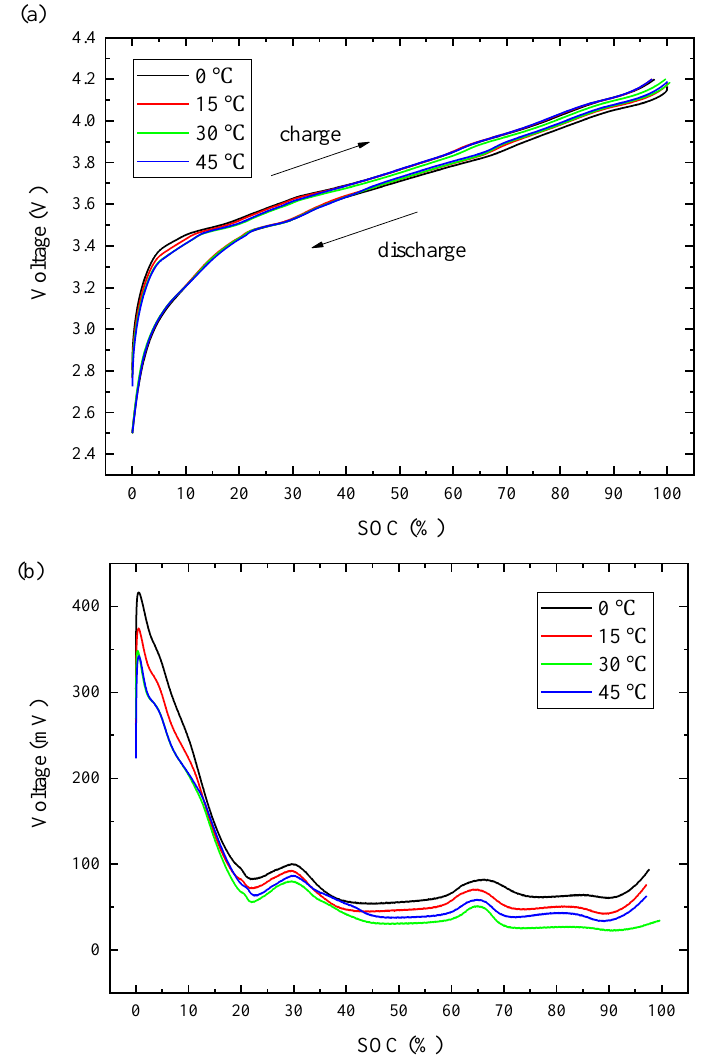
Figure 7. The OCV and hysteresis level under different temperatures: ( a ) the OCV boundaries of discharge and charge process at different temperatures; ( b ) the hysteresis voltage level.